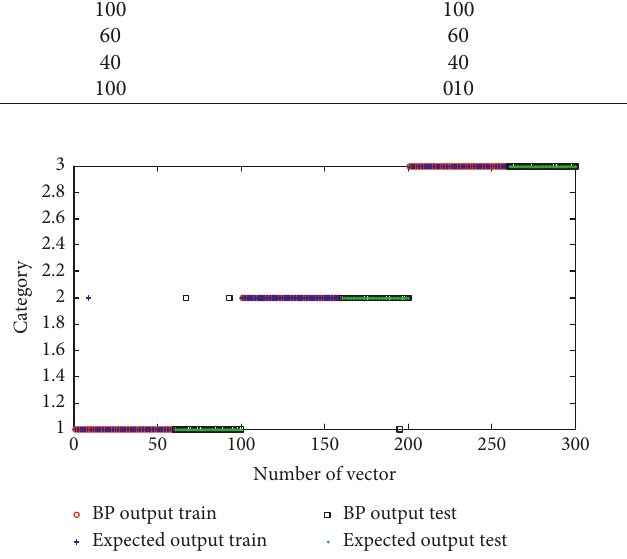
Figure 23: The classification results of roller bearing